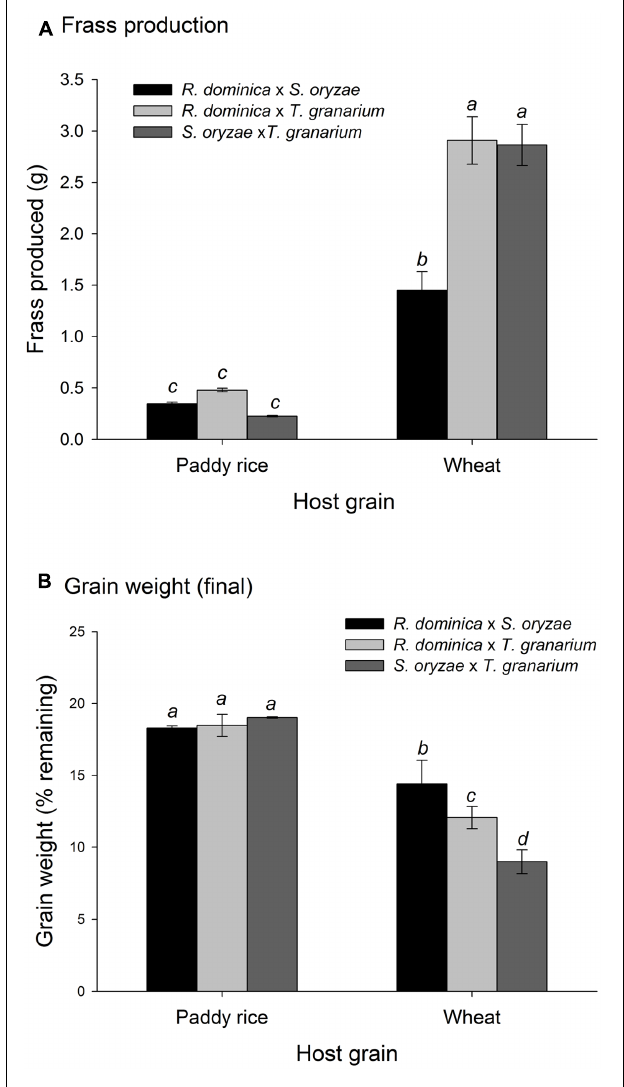
FIGURE 6 | Frass production (A) and final grain weight (%) (B) by insect populations under two-species competition in grains of two cereal host species, paddy rice and wheat. The histogram bars refer the average of nine replicates and the vertical bars represent standard errors of the mean. Histogram bars with the same letter are not significantly different by Tukey’s HSD test ( P <